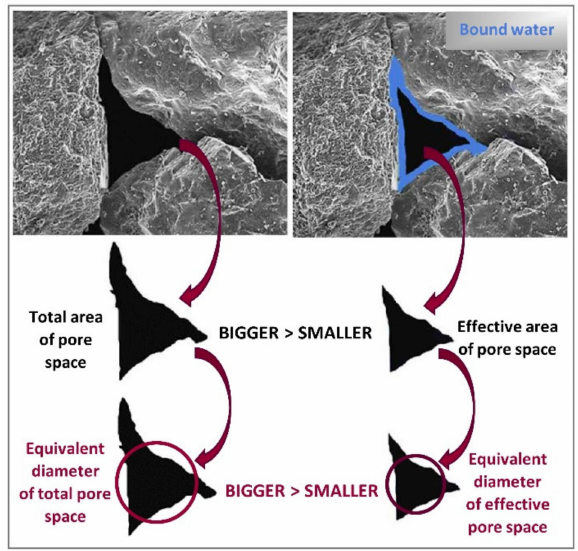
Figure 2. Pore space analysis based on SEM image.